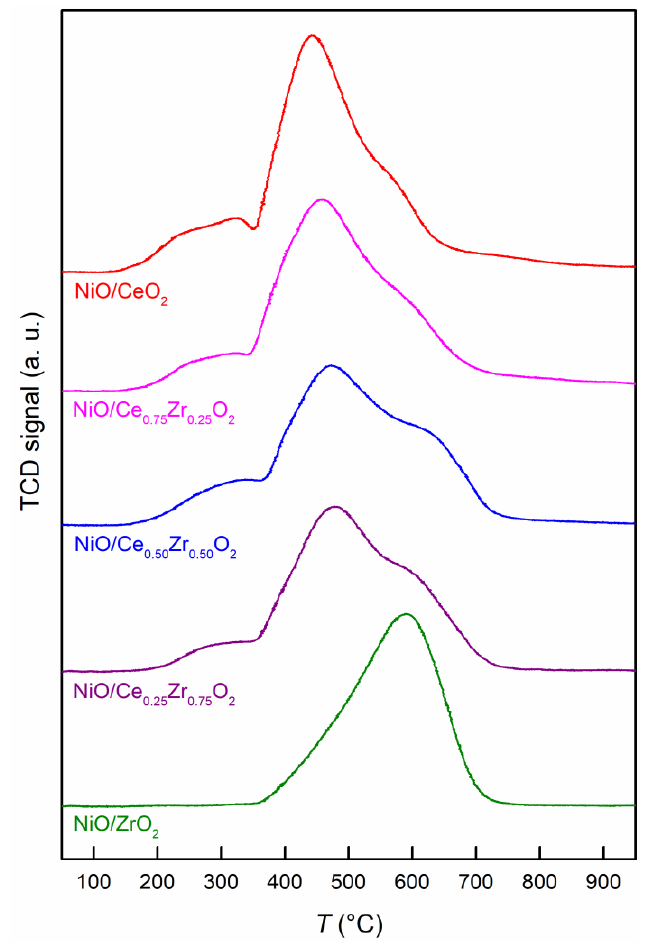
Figure 3. TPR curves of the NiO/Ce x Zr 1- x O 2 samples.